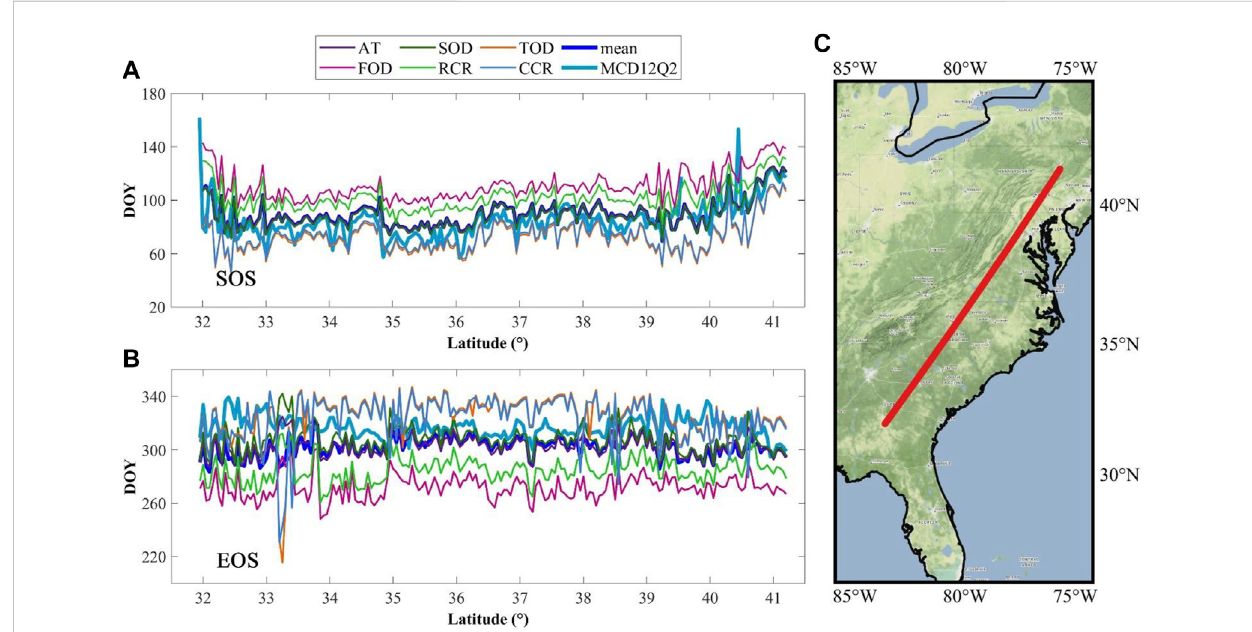
FIGURE 5 Pro fi le ofthestartofseason(SOS)and theendof season (EOS)in2017 derived fromtwodifferentdata sources. (A) Pro fi leofSOS; (B) pro fi le ofEOS; (C) location ofthepro fi le.The average value ofphenophaseswascalculated every 0.05 ° alongthe pro fi le.MCD12Q2 denotesthephenophasesobtained from the MCD12Q2 product; AT, FOD, SOD, RCR, TOD, and CCR denote the phenophases estimated from the MOD09Q1 EVI2 time series using corresponding methods, and “ mean ” denotes the average value of the phenophases estimated from the fused EVI2 time series by six